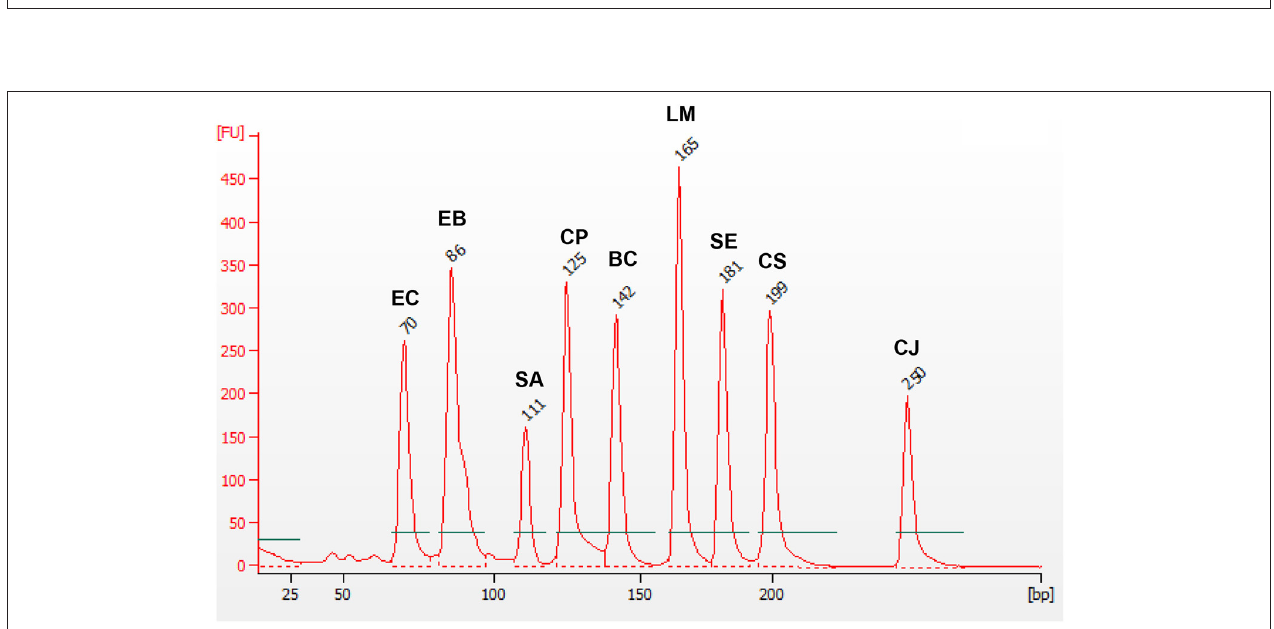
FIGURE 1 | Amplicons obtained by mPCR with primer pairs designed for: E. coli (EC), F. Enterobacteriaceae (EB), St. aureus (SA) , Cl. perfringens (CP), B. cereus (BC), L. monocytogenes (LM), Salmonella spp. (SE), Cr. sakazakii (CS), and C. jejuni (CJ). Values showed on peak’s top, corresponds to the size detected for each amplicon in bp.